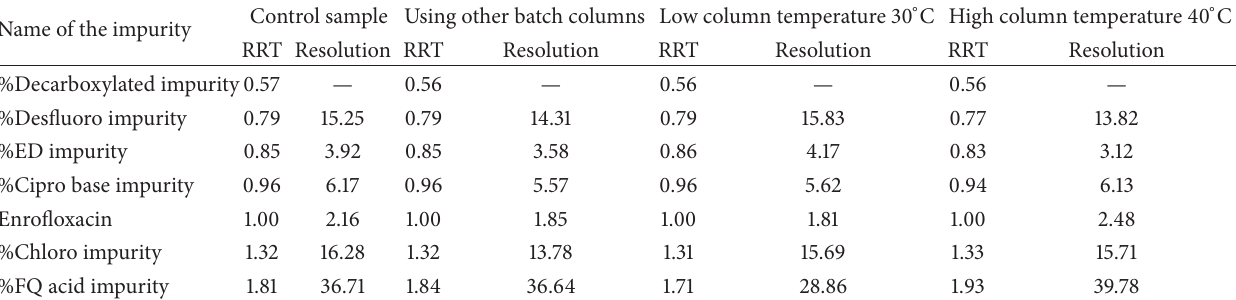
Table 9: Robustness results (control sample and column temperature variations).